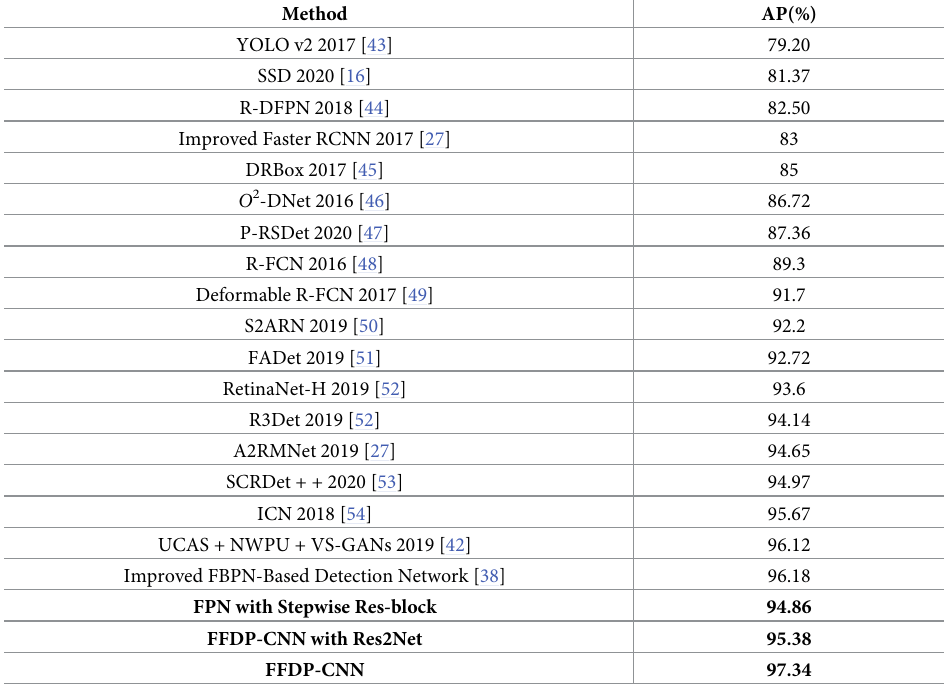
Table 7. Comparison between proposed framework and other methods on